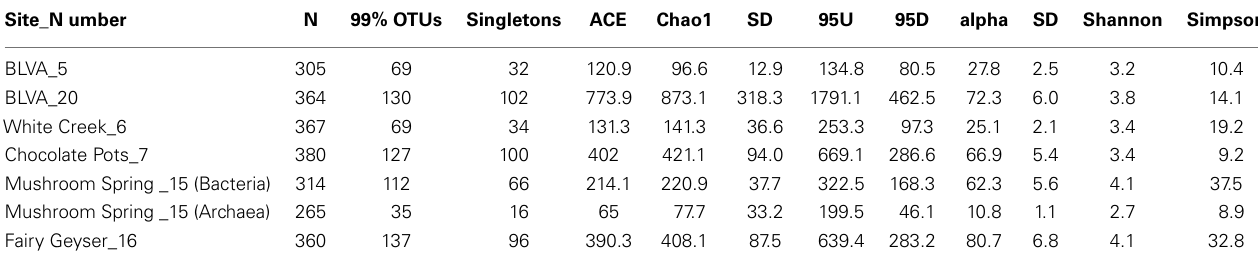
TableA1 | Community diversity estimated from 16S sequence libraries.